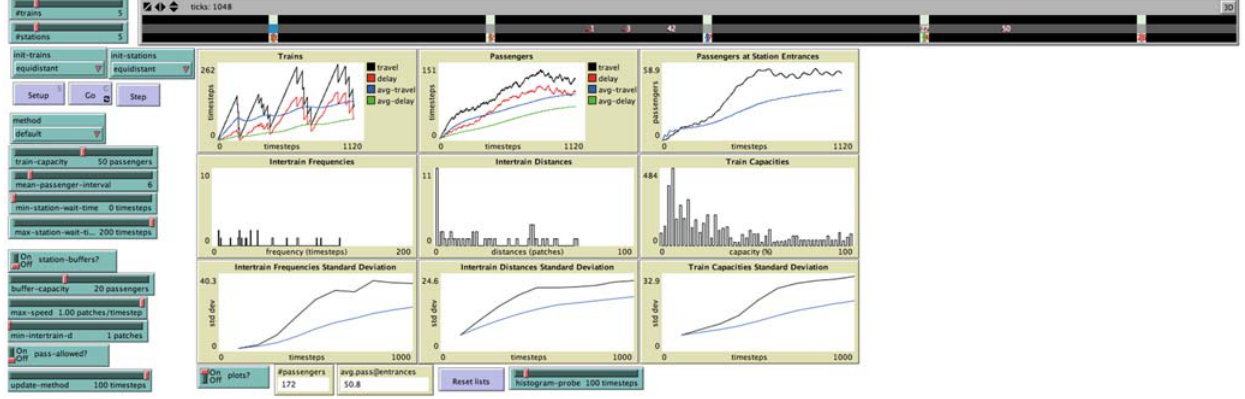
Figure 2. Screenshot of the simulation with equal headway instability, l ~ 6 . The track, vehicles and passengers are shown on the top, where numbers indicate the passengers in vehicles or waiting at stations. Different parameters of the simulation (some not relevant to the results presented here) can be adjusted. Different monitors, plots, and histograms show results in real time. The equal headway instability can be seen most clearly in the histograms: the intervehicle frequencies are irregular, as well as the intervehicle distances (with a sharp peak at d v ~ 1 , i.e. vehicles aggregated next to each other). This irregularity leads to high standard deviations. Notice also that the vehicle utilization (percentage of vehicle capacity used) has a very broad distribution, i.e. there are some vehicles working at almost full capacity, while many vehicles have a very low capacity utilization.